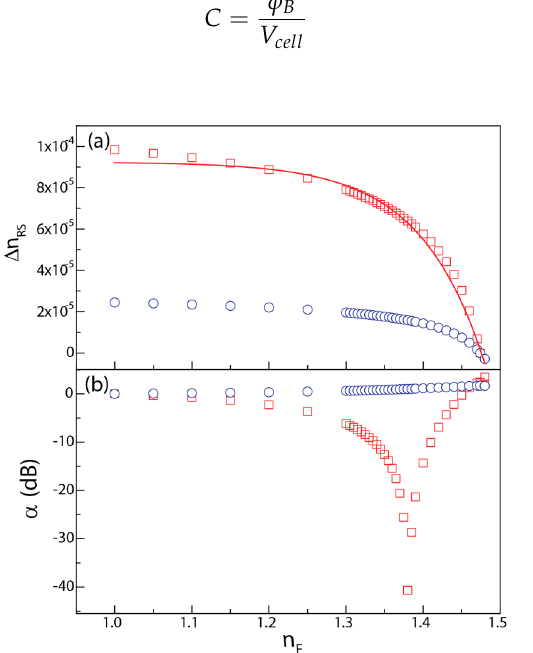
Figure 3. ( a ) ∆ n RS and ( b ) α as a function of n F for TE ( ○ ) and TM polarizations ( □ ). The red line represents the data-best fit (r 2 > 0.99) for 1.000 ≤ n F ≤ 1.500 (characteristic for air and E. coli cells [32]), using a single exponential decay ( ∆ n RS = y 0 + A × e ( − n F / t ) , with y 0 = (9.3 ± 0.1) × 10 − 6 , A = − 1.9 × 10 − 12 and t = − 8.40 ± 0.04 × 10 − 2